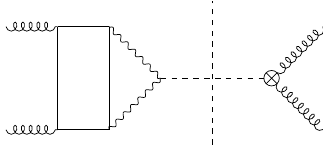
G (0) of eq. (2.4). The vertical lf HT